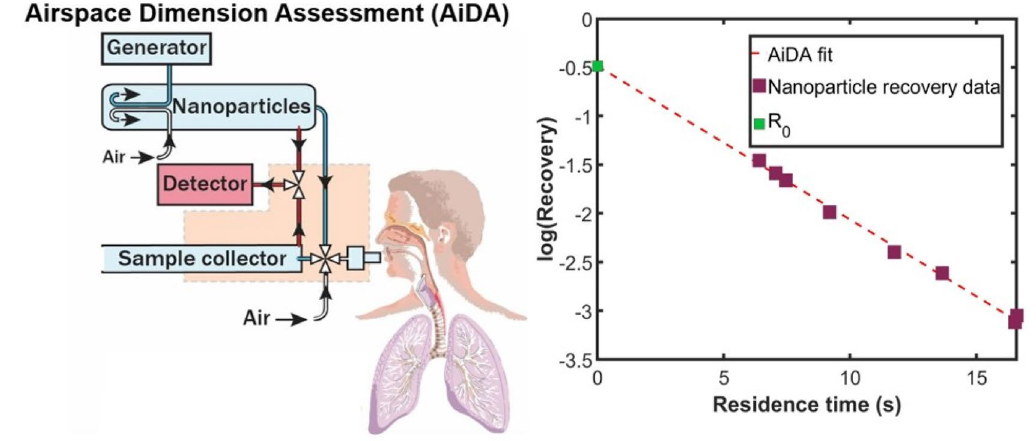
Figure 4. (Left) Schematic illustration of the AiDA method. The aerosol particles from the distal airspaces were sampled to obtain the distal airspace radius r AiDA and the zero-second recovery R 0. (Right) Representative recovery data as a function of residence time in the lungs and AiDA fit obtained for one